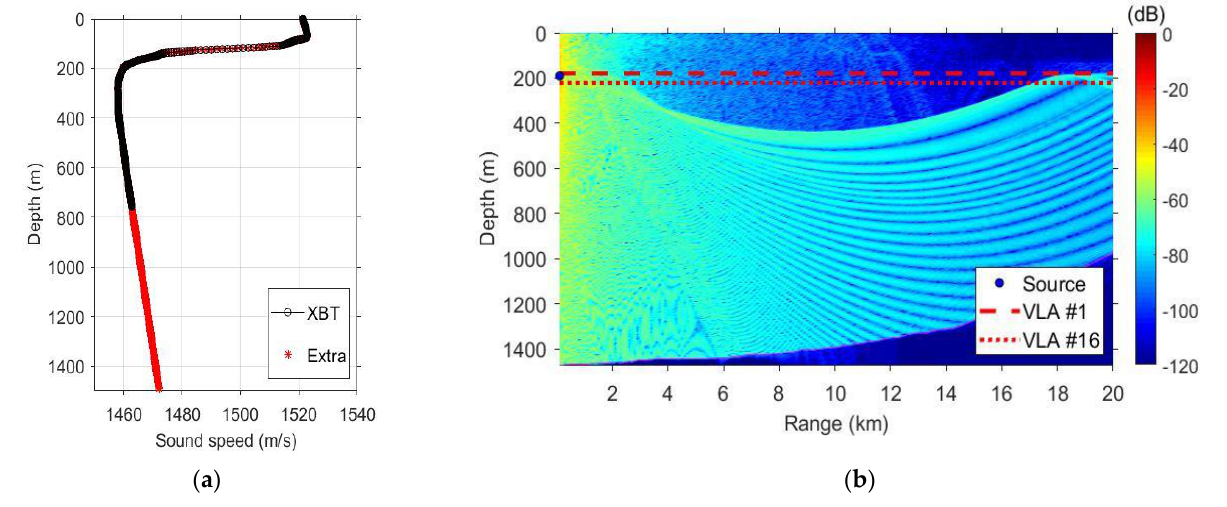
Figure 11. Underwater channel in the sea trial: ( a ) sound speed profile and ( b ) transmission loss.